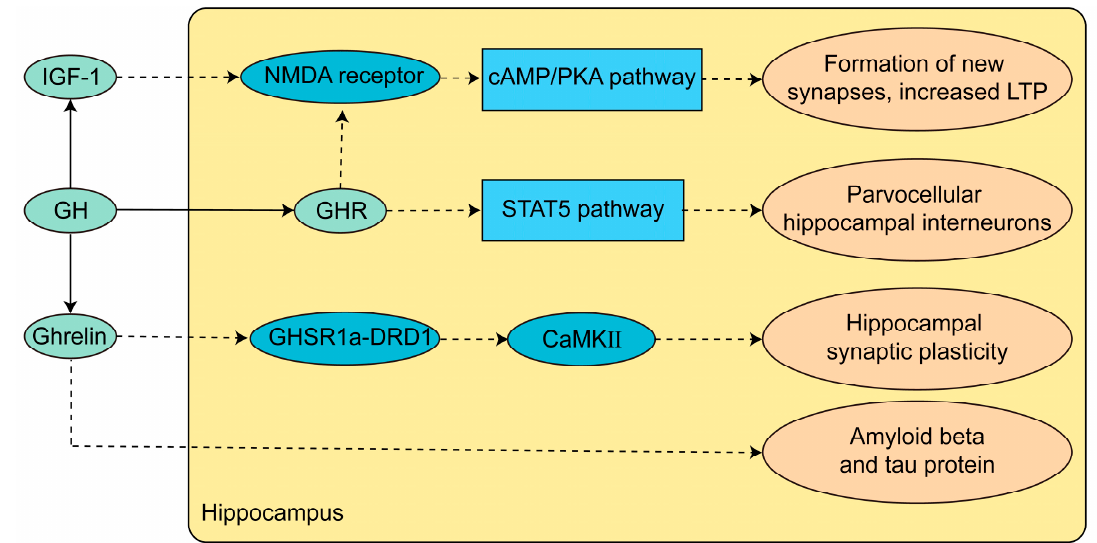
Figure 1. Pattern of GH and IGF-1 action in the hippocampus. GH acts on parvocellular hippocampal interneurons by activating the STAT5 pathway in order to regulate hippocampal development. GH and IGF-1 activate the cAMP-PKA pathway through NMDA receptors to enhance LTP. Excess GH negative feedback decreases ghrelin and affects synaptic plasticity in hippocampal dopamine neurons. Ghrelin has also been implicated in the development of Alzheimer’s disease. Solid arrows indicate a direct interaction, dashed arrows indicate an indirect interaction. Abbreviations: IGF-1, insulin-like growth factor-1; NMDA, N-methyl-D-aspartate; cAMP, cyclic adenosine monophosphate; PKA, protein kinase A; LTP, long-term potentiation; GH, growth hormone; GHR, growth hormone receptor; STAT5, signal transducer and activator of transcription 5; GHSR1a, growth hormone